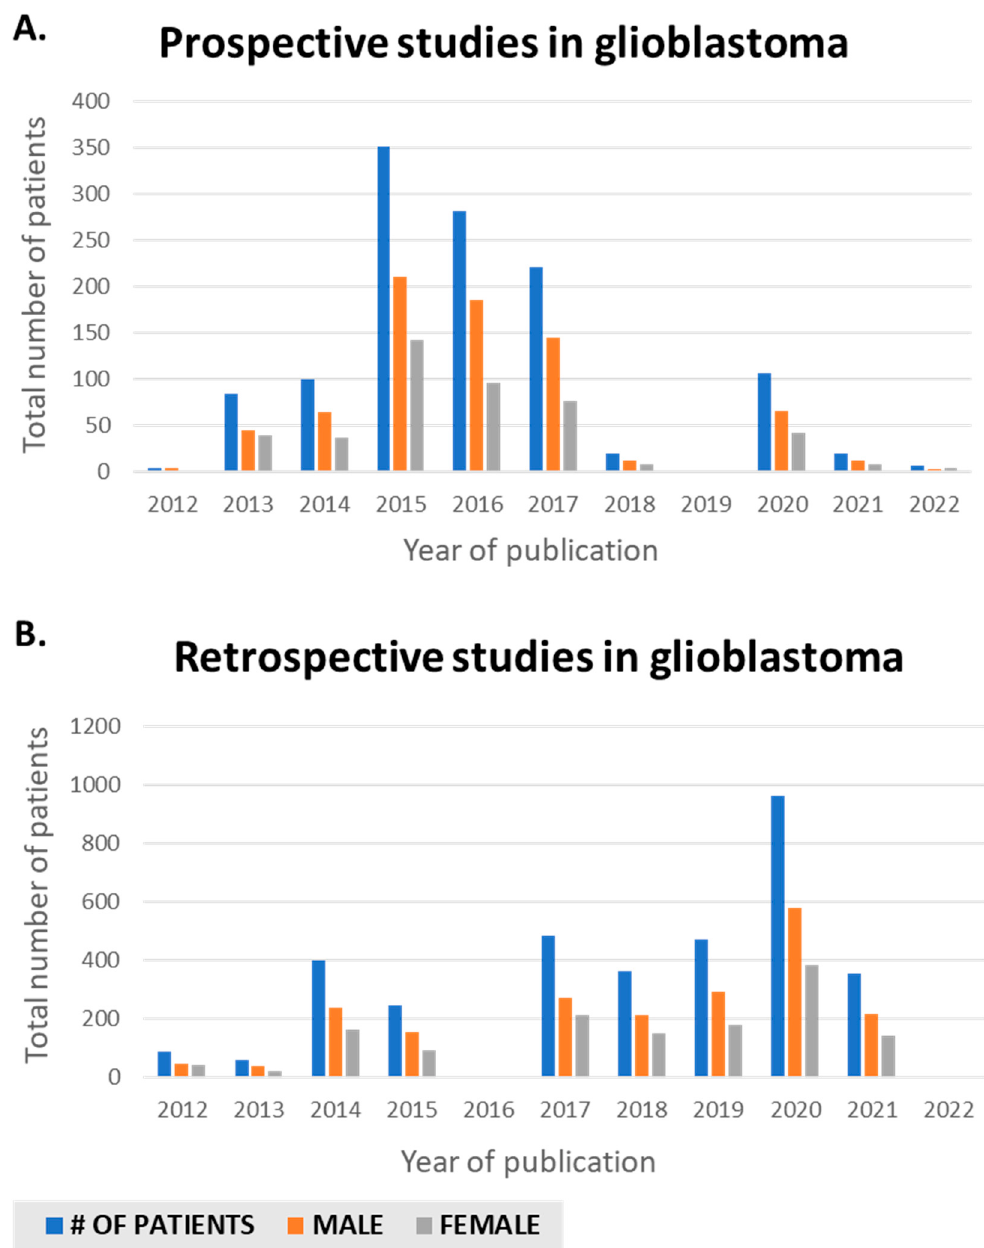
Figure 1. Sex differences publications in glioblastoma in PubMed from 2012 to present. ( A ) Retro- spective. ( B ) Prospective. Table 1. Retrospective studies in glioma illustrating the number of patients included in the study with % female inclusion and generated conclusions.